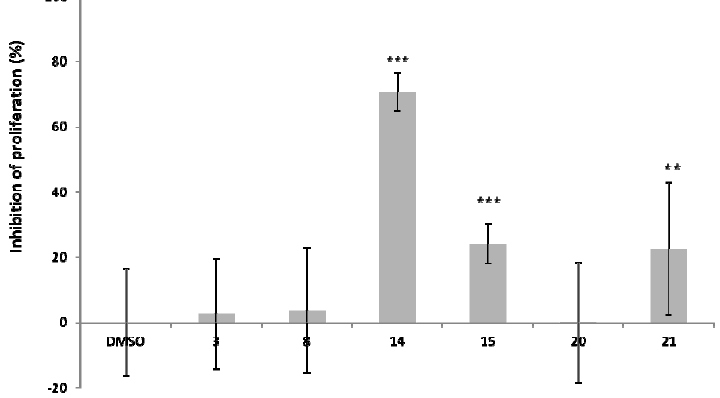
Figure 2. Inhibitory activity of synthetic procyanidin B proliferation. HeLa S3 was incubated with final 100  M of each compound for 24 h. All error bars represent standard deviations of the mean. *** p < 0.001, ** p < 0.005 vs. DMSO-treated